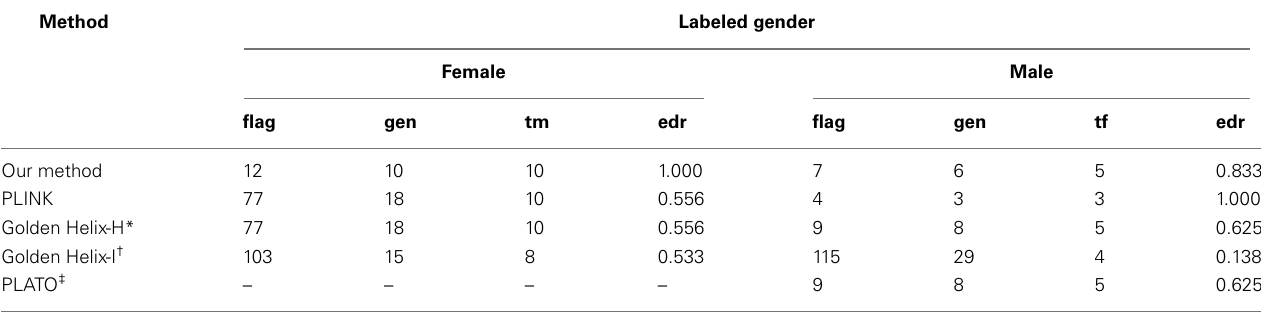
Table 5 | Method-specific numbers of flagged samples (flag) with true gender ascertained (gen), numbers of confirmed gender errors (tf = true female, tm = true male) among these, and error discovery rate